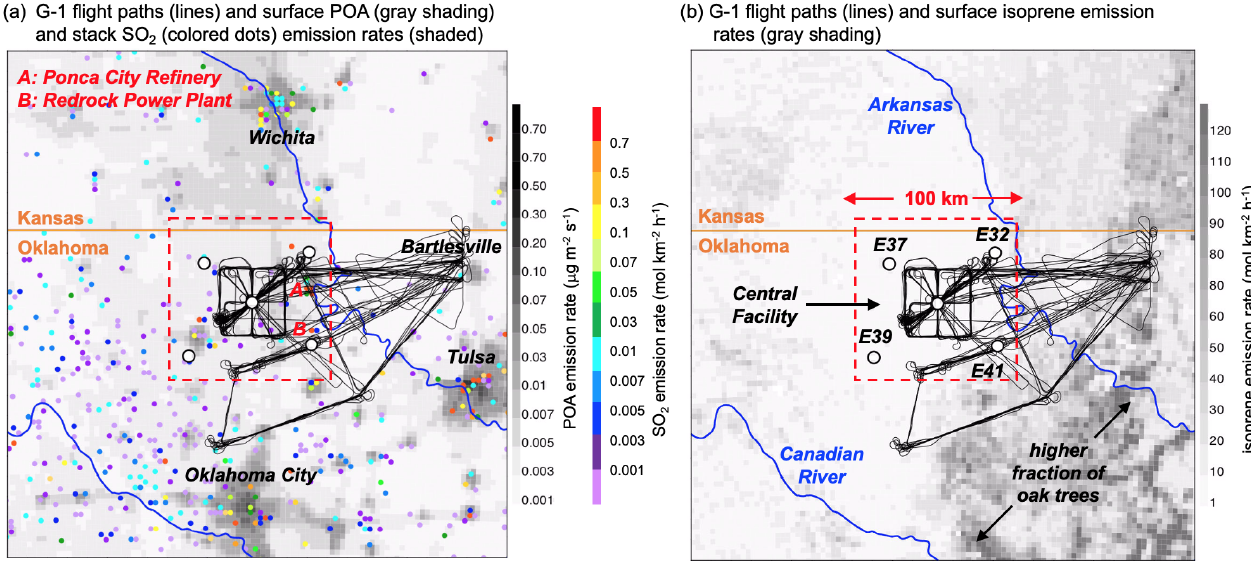
Figure 1. G-1 flight paths near the ARM SGP site over northern–central Oklahoma during IOP 2 along with (a) surface POA (gray shading) and stack SO 2 (colored dots) emissions and (b) surface isoprene emission rates (gray shading). Open circles denote primary SGP site vertical profiling measurement